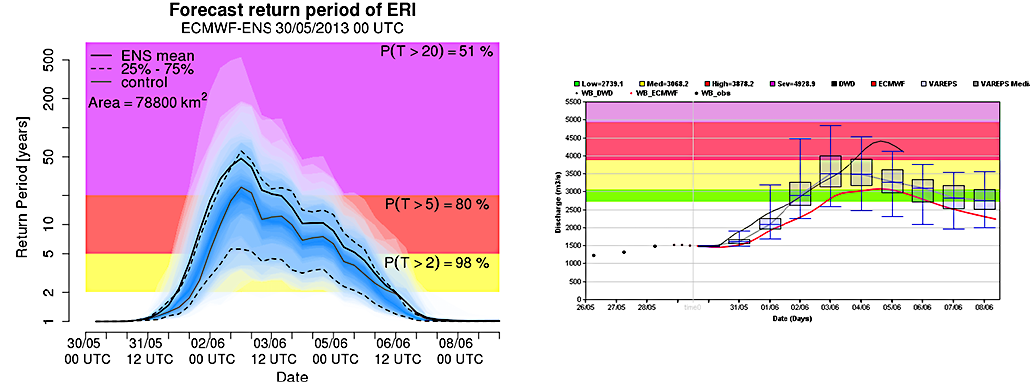
Figure 11. Comparison between 10-day ensemble forecasts of the ERI (left) and the EFAS multi-model (right) for